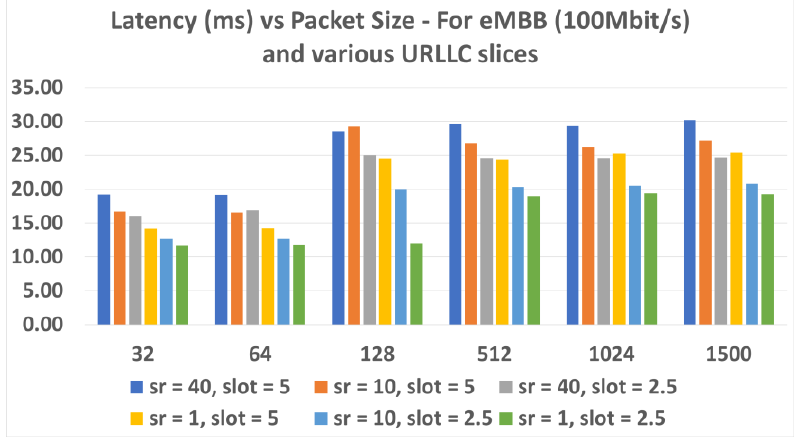
Figure 5. Latency results for a 100 (Mbits/s) eMBB slice and 6 different uRLLC slices. Furthermore, in the third set of experimental tests an eMBB slice of 200 Mbits/s was allocated, and the same set of RAN uRLLC slice parameters were enforced. The results, as depicted in Figure 6, indicate a similar behavior to the eMBB slice results of 100 Mbits/s, with the case of 128 byte packets again demonstrating the largest improvement.